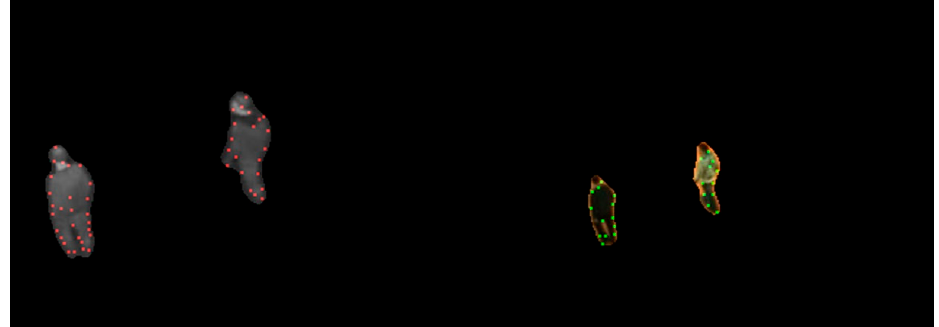
Figure 3. Keypoints found using the CSS corner detection algorithm in infrared (red dots) and in visible images (green dots).